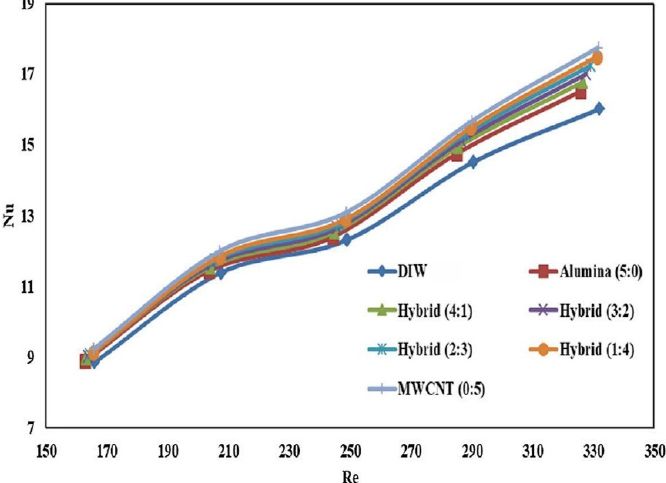
Figure 15. Variations of Nu number versus Re number in different ratios of the Al 2 O 3 and MWCNT nanoparticles. Reproduced with permission from [188]. Elsevier, 2019.